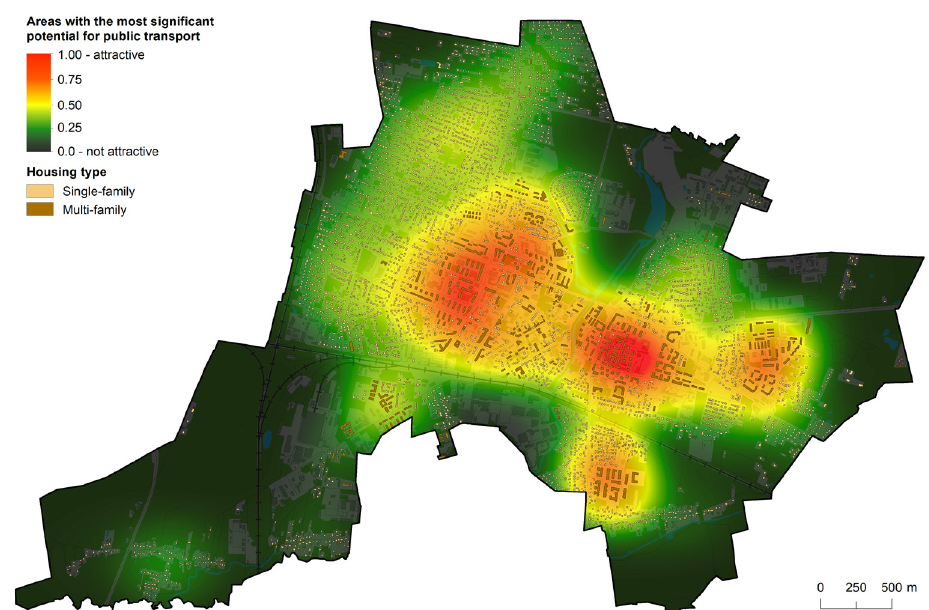
Fig. 2. Areas with the most significant potential for public transport in means of